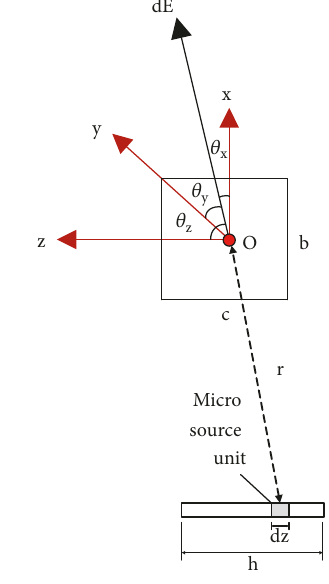
Figure 3: Field strength of microsource